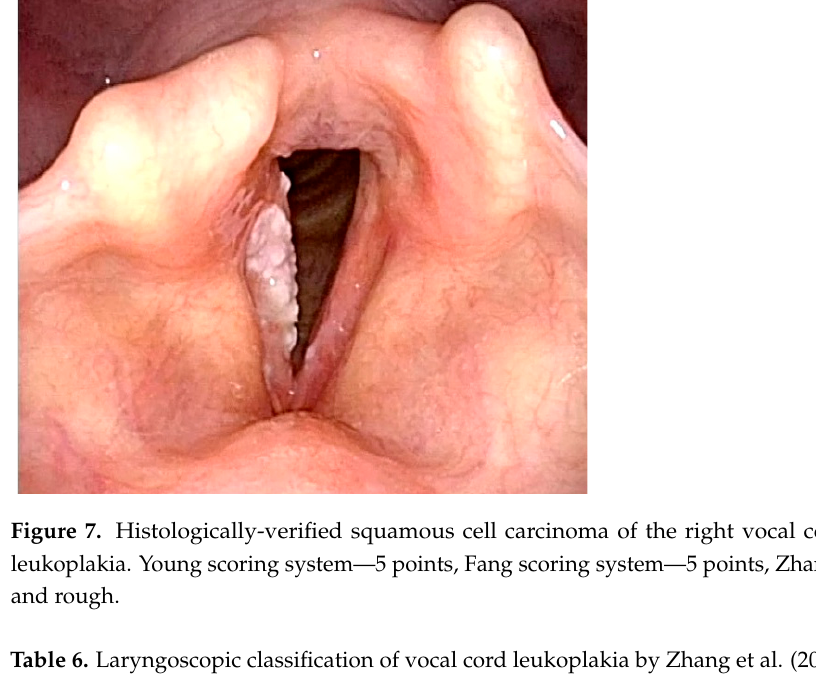
Figure 6. Histologically-verified parakeratosis of the right vocal cord presenting as leukoplakia.